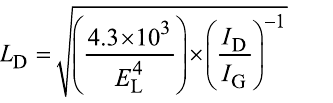
figure one can notice the difference in intensity of ≈ 2959 cm − 1 (I), 2921 cm − 1 (II) and 2849 cm − 1 (III) bands, corresponding to rGO and rGO-MNPs ν as CH 3 and ν as / ν s CH 2 stretching, respec- tively. This effect could be related to the defect sites